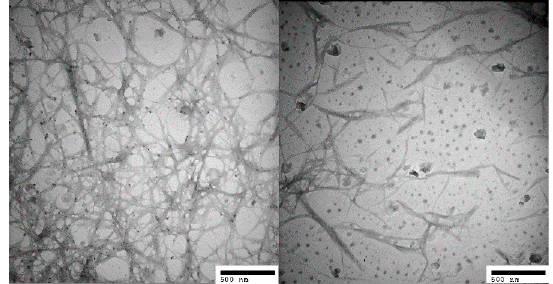
Figure 4. Transmission electron microscope images of LCN.